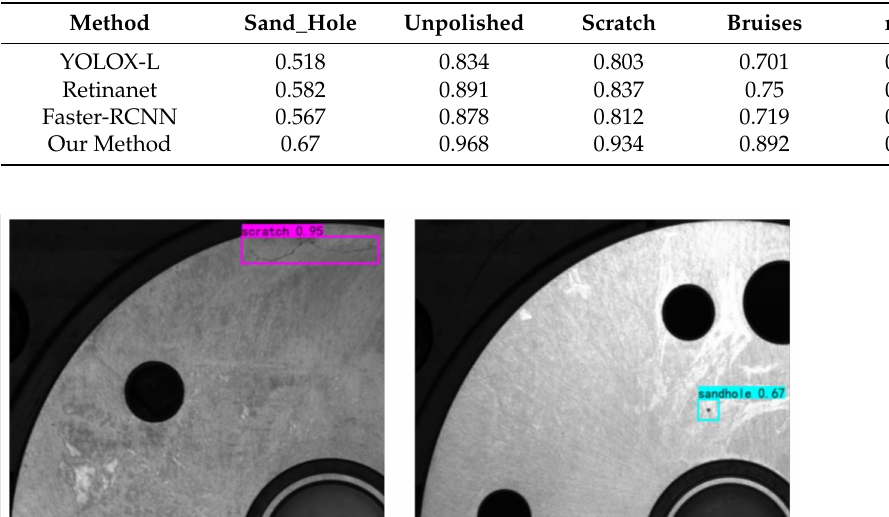
Table 1. Performance of different models on the flange surface defect dataset.